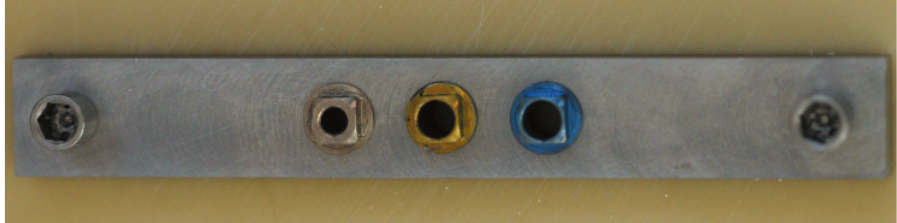
Figure 2- !"#$"%&%' ( )*'+ ,"-"./,"0&0 .*%12 34&0 "%'" '+& $"-56.&'+7%& 8-",9 )*'+ +".*:"%'7- 2,.&)2 '" 2'7%07.0*:& locations for implant